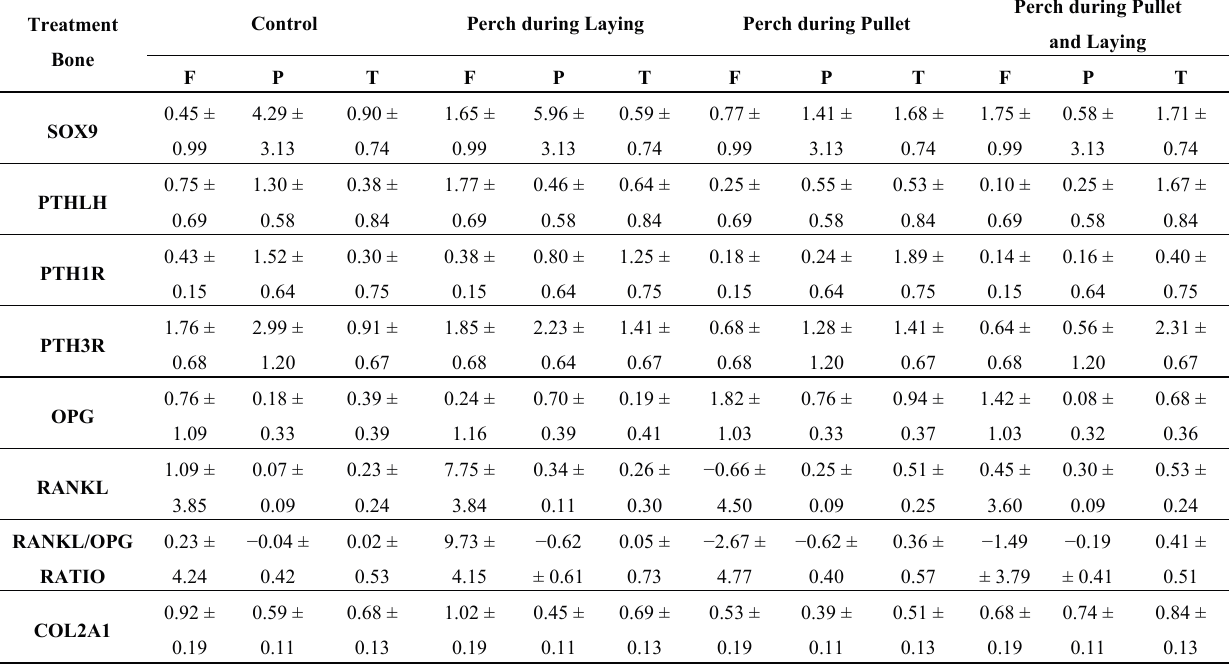
Table A1. Mean expression among treatment and bone combinations (least squares mean ± SE). Negative least squares means arise when the measured expression is highly variable among replicates and includes missing values for some replicates (particularly for OPG and